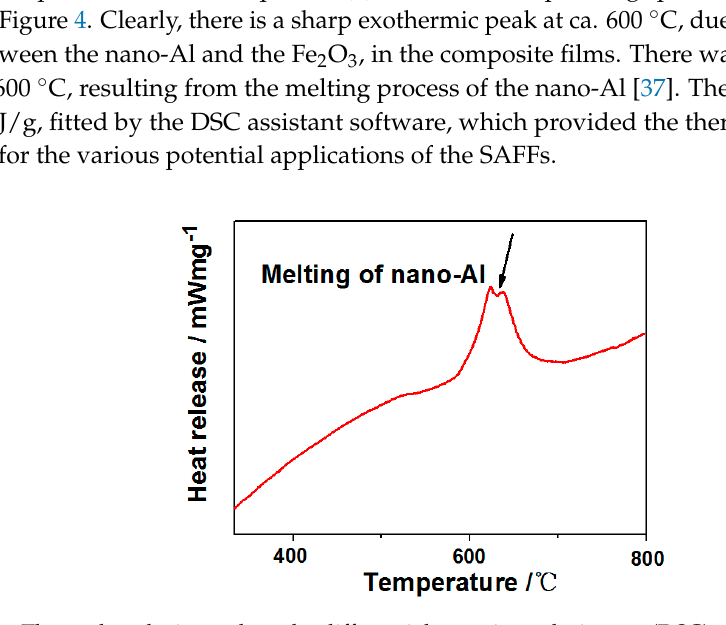
Figure 4. Thermal analysis results—the differential scanning calorimetry (DSC) curves of the SAFFs.